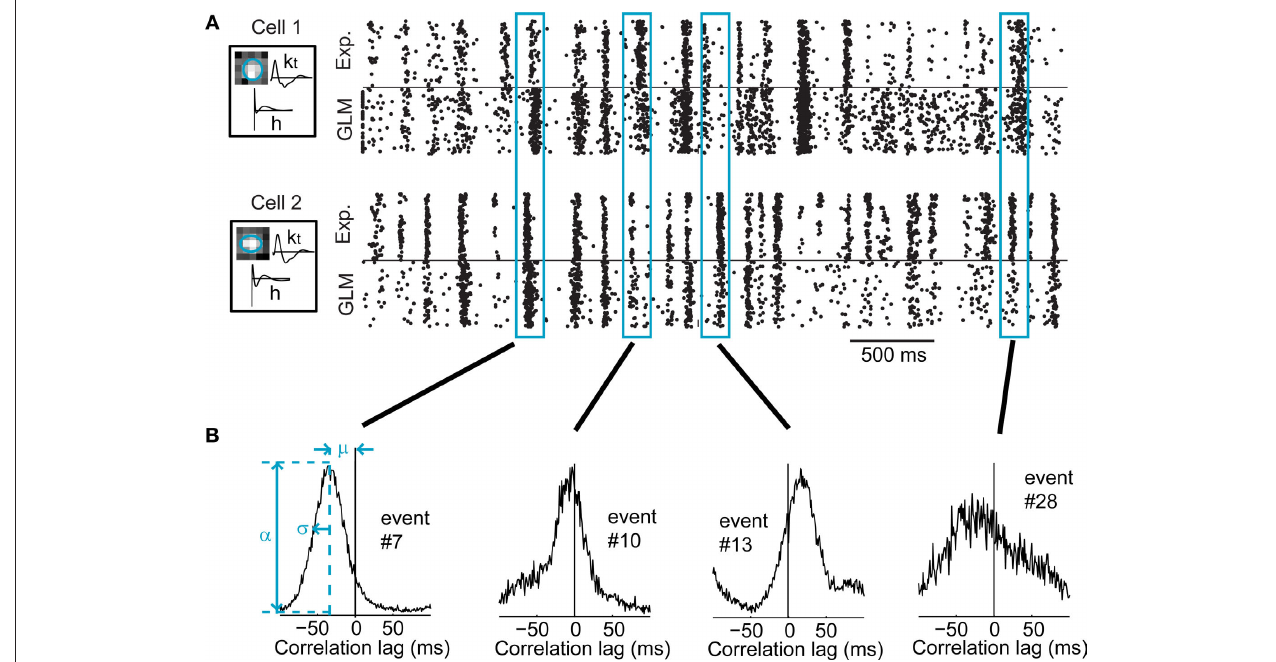
cross-correlation functions computed from GLM simulations of four different events shared by the two above cells. Whereas only 120 simulated trials are shown in (A) , 10,000 trials were simulated to compute these local cross- correlations. The left panel shows how the peak correlation value ( α ), the mean latency (μ), and the cross-correlation width ( σ , the standard deviation of the best-fitting Gaussian) were defined.